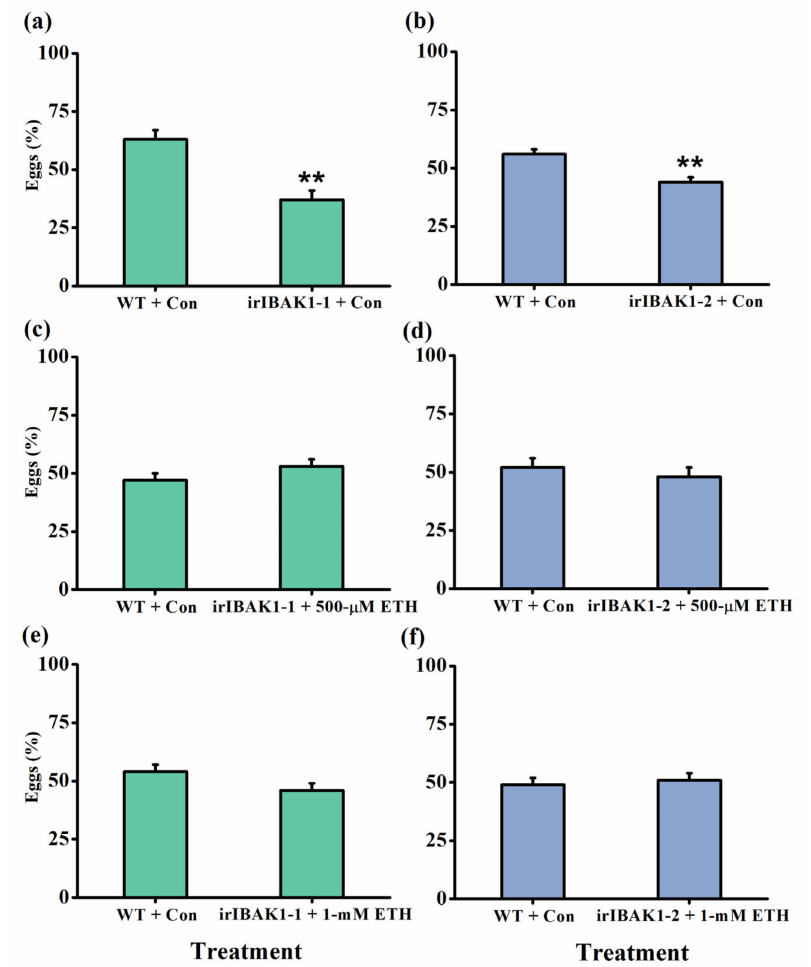
Figure 7. Spraying ethephon abolishes the difference in oviposition preference of BPH for WT and ir- ibak1 plants. ( a , b ) Mean percentage (+SE, n = 10) of BPH eggs per plant on pairs of plants (WT versus irIBAK1-1 or irIBAK1-2) that were sprayed with ddH 2 O (with 0.02% Tween-20) 48 h after the release of BPH. ( c – f ) Mean percentage (+SE, n = 10) of BPH eggs per plant on pairs of plants, WT plants that were sprayed with ddH 2 O (with 0.02% Tween-20) versus irIBAK1-1 or irIBAK1-2 plants that were sprayed with 500- µ M ethephon (ETH) ( c , d ) or WT plants that were sprayed with ddH 2 O (with 0.02% Tween-20) versus irIBAK1-1 or irIBAK1-2 plants that were sprayed with 1-mM ETH ( e , f ) 48 h after the release of BPH. Con, control solution. Asterisks represent significant differences between the treated plants and control plants (** p < 0.01; Student’s t